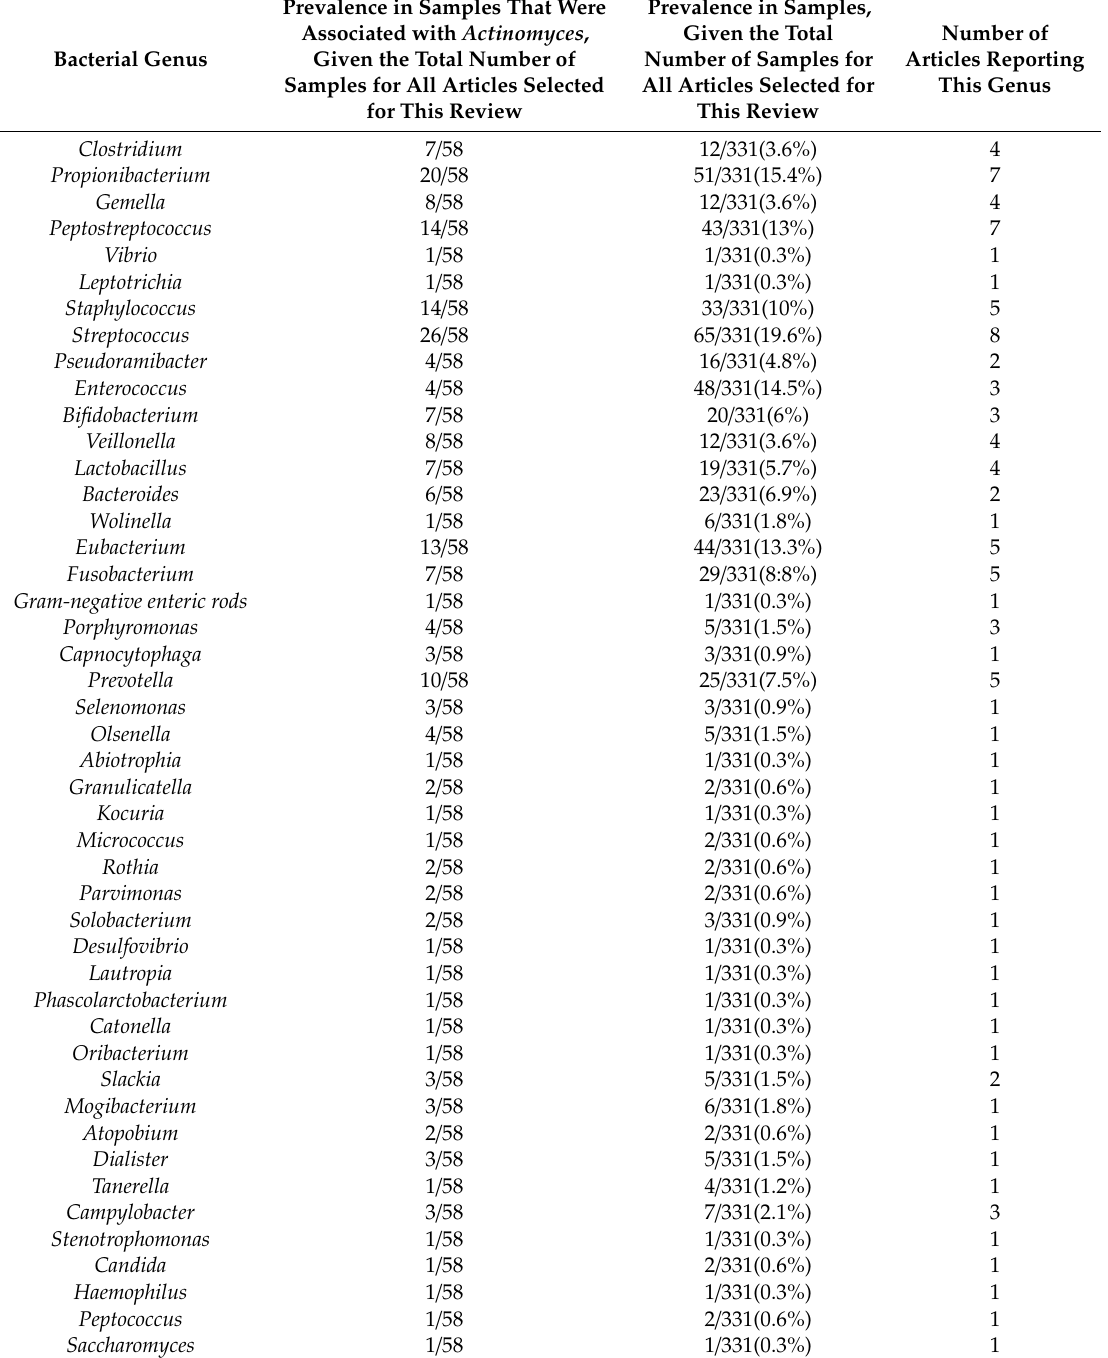
Table 4. Total prevalence of bacterial genera in association with Actinomyces with respect to all samples, as well as the total number of samples for all articles selected for this review. The total number of positive samples for each single bacterium is also